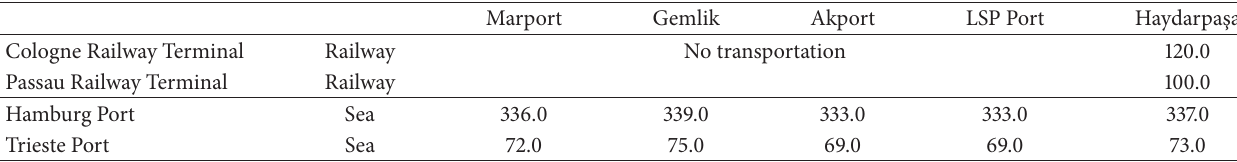
Table 6: Transportation times between the first and the second transshipment terminals (hour/unit